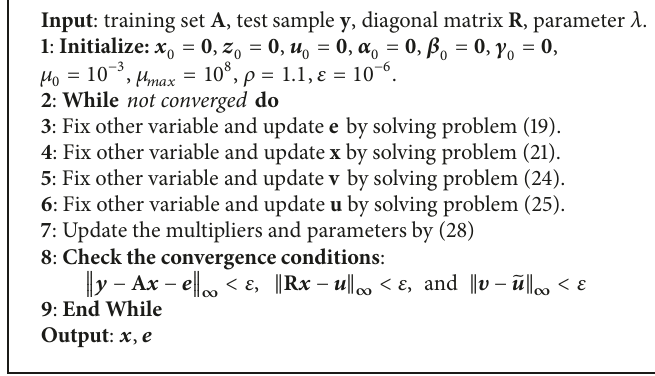
Algorithm 1: SolvingCoLR model based on